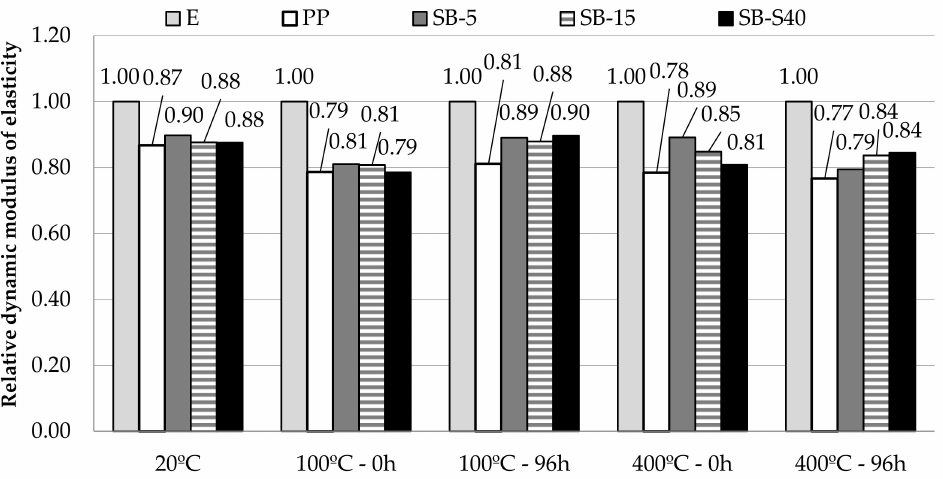
Figure 7. Residual dynamic modulus of elasticity of reinforced concretes compared with reference mixture E under the same testing